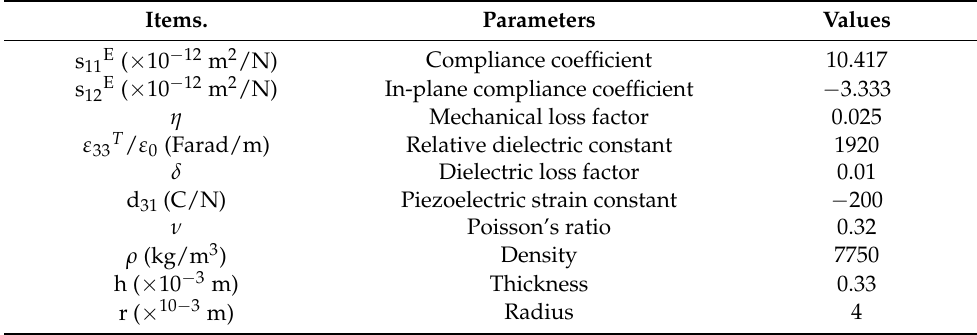
Table 1. The characteristic properties of circular PZT sensors. Items.